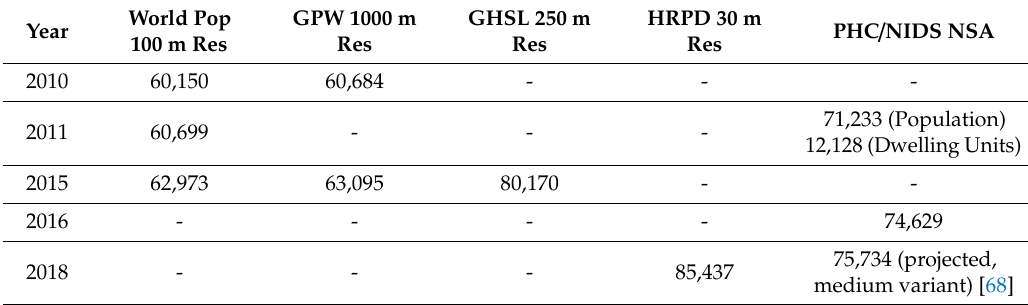
Table 6. Total Population estimates for Omaheke.